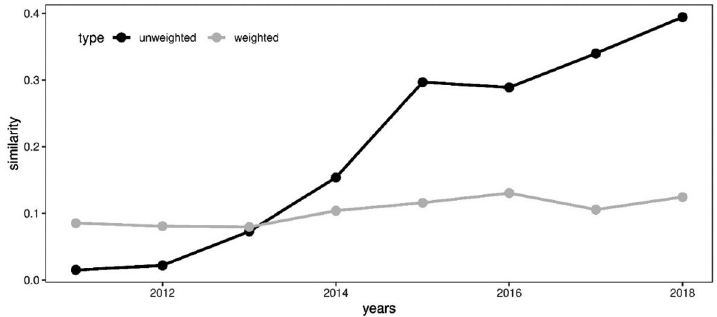
Figure 3. The similarity in the publications’ keywords presence in both publications and tweets (2012–2018) (source: own study based on Web of Science, Scopus, and Twitter)